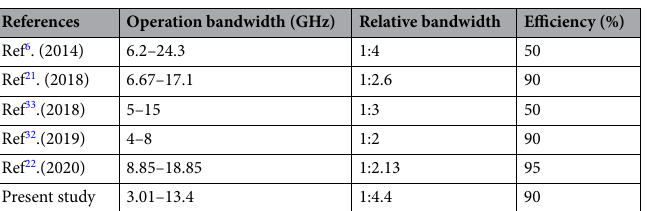
Figure 7. The fabricated sample (a) and the experimental setup (b) with measurements. The simulated and measured polarization reflection (c) versus frequency under normal incidence and the PCR (d) for the converter under a y -polarized incident wave.